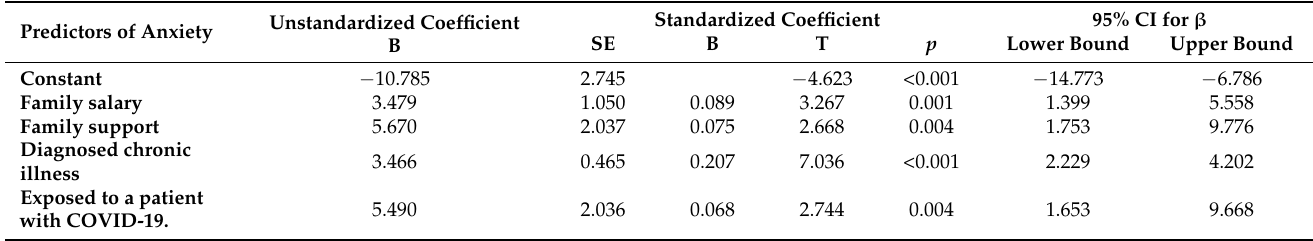
Table 4. Linear regression model of sociodemographic characteristics that predict anxiety.